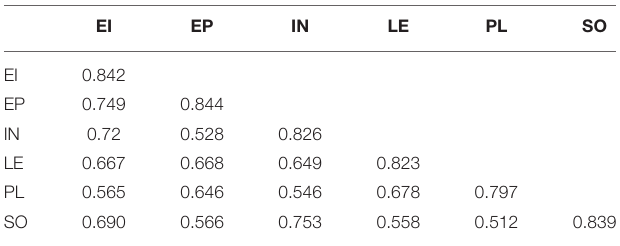
TABLE 3 | Fornell–Larcker ratio criterion.